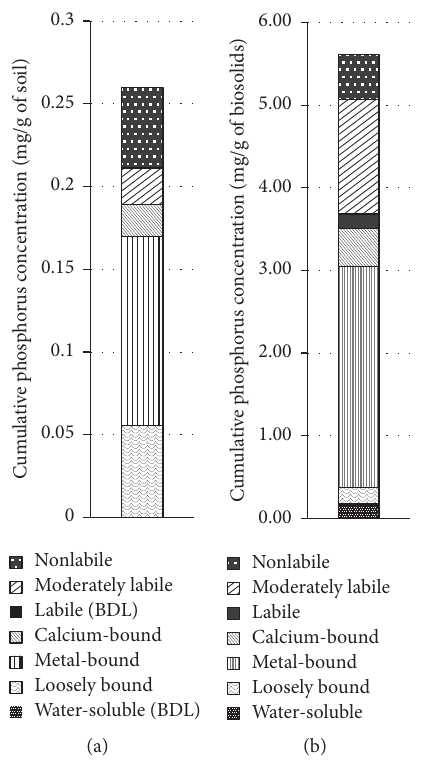
Figure 1: Cumulative initial phosphorus fractions in soil (a) and biosolids (b). Note different concentration scales between the two